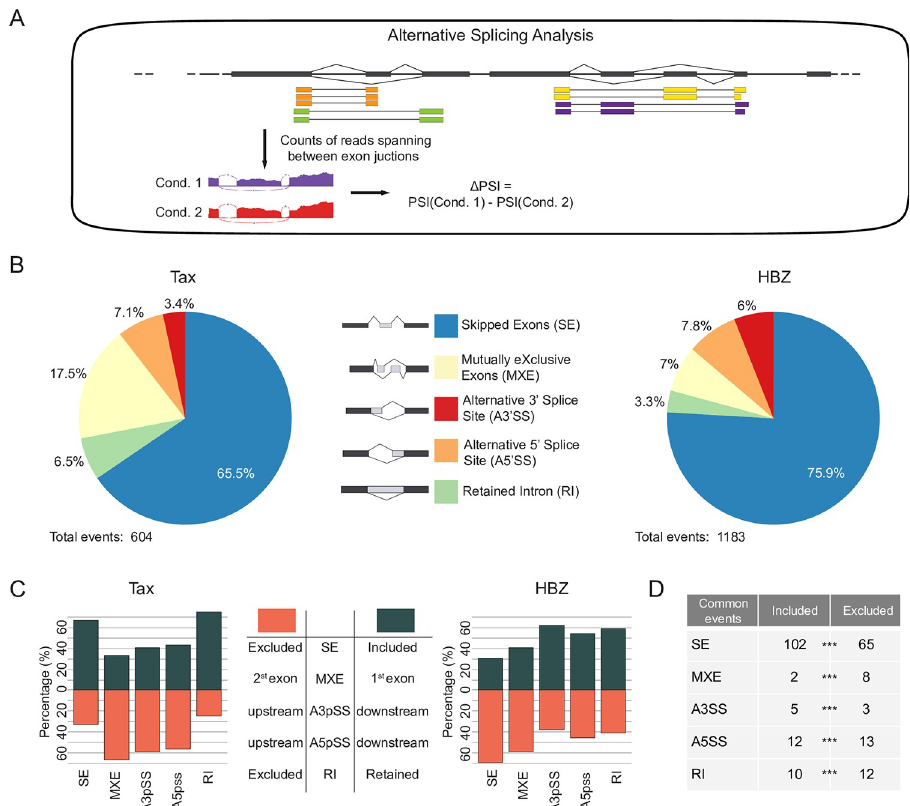
Fig 3. Impact of Tax and HBZ expression on cellular gene alternative splicing events. (A) Differential alternative splicing between Tax or HBZ expressing conditions and control conditions were analysed with rMATS (n = 3 for each condition). Following alignment with STAR, exon inclusion levels are assessed using reads that are mapped to both regulated exons/introns and spliced junctions. rMATS determines the Percent Spliced In (PSI) in each condition and evaluates the difference in PSI ( Δ PSI) of alternative splicing events. Significant events were then user-filtered first by discarding genes with low TPM and keeping AS events with a | Δ PSI| � 0.1 (i.e. 10%) and a FDR < 0.05. (B) Splicing profiles of ASEs detected in Jurkat cells expressing Tax (left) or Flag-HBZ (right). SE = Skipped Exon, MXE = Mutually Exclusive Exons, A3’SS = Alternative 3’ Splice Site, A5’SS = Alternative 5’ Splice Site, RI = Retained Intron. (C) Exclusion or inclusion of ASEs observed in Tax and Flag-HBZ expressing conditions. (D) Number of shared ASEs between Jurkat cells expressing Tax or Flag-HBZ. ��� = p-value < 0.001. See also S4 Fig and S3